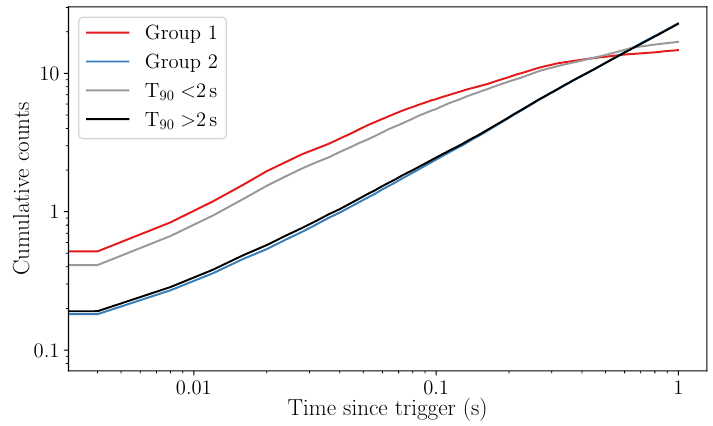
Figure 11. Normalised cumulative counts of Band 3 (50–100keV) Swift /BAT 4ms light curves. Short (T 90 < 2s) and long (T 90 > 2s) duration bursts, and those within the Groups 1 and 2 identified from the first 1s of prompt emission, are